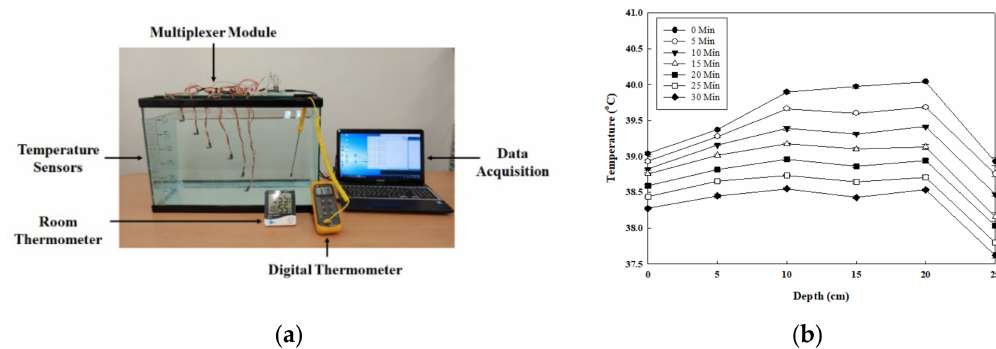
Figure 2. Experiment for observing the relationship between water temperature and depth: (a) picture of experiment setup; (b) result of the relationship between water temperature and depth over